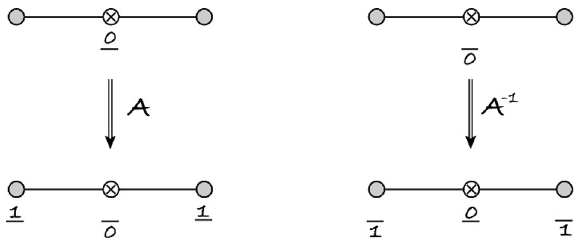
Figure 4 . Transformation rules for the overlaps.